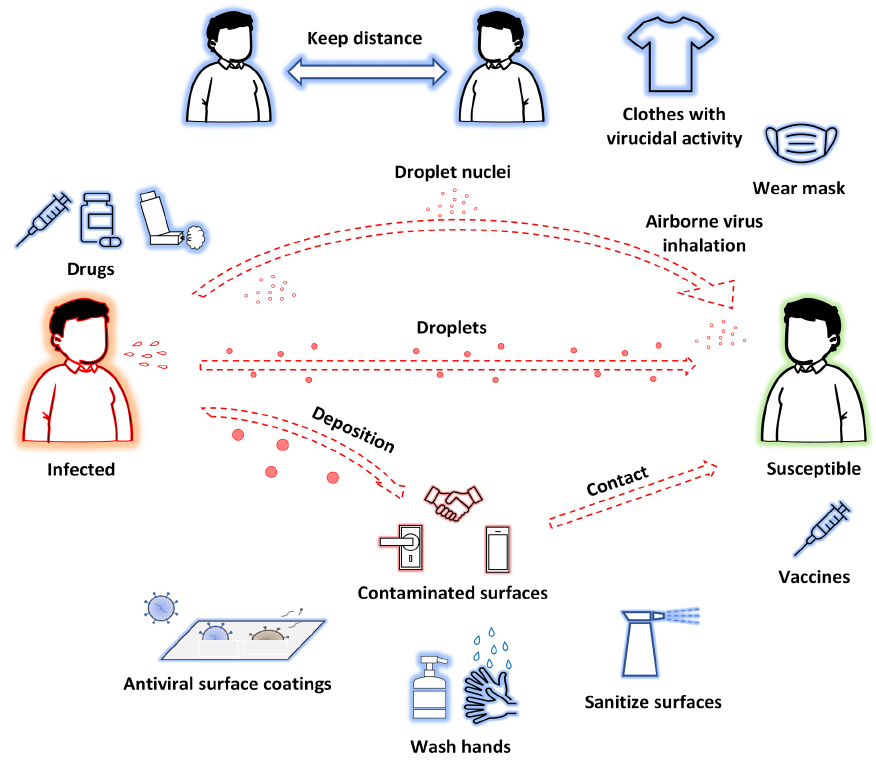
Figure 1. Transmission methods of SARS-CoV-2 and possible approaches to prevent and treat